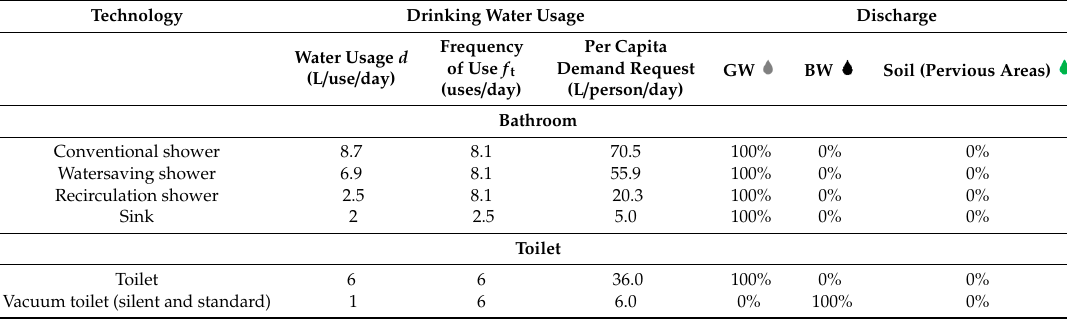
Table A1. Water usage and per capita consumption on SUPERLOCAL appliances.